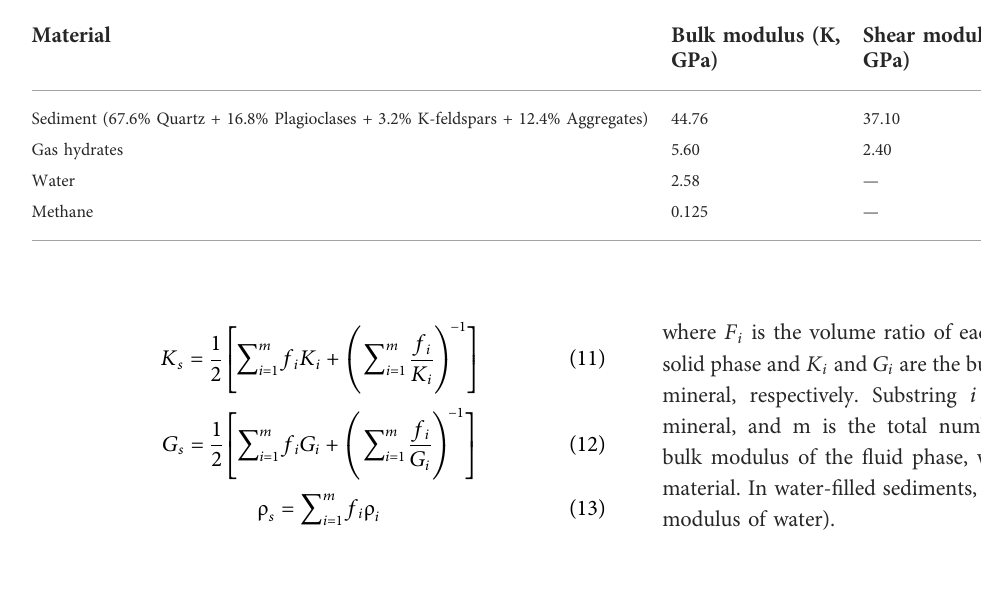
TABLE 1 Elastic modulus and density of